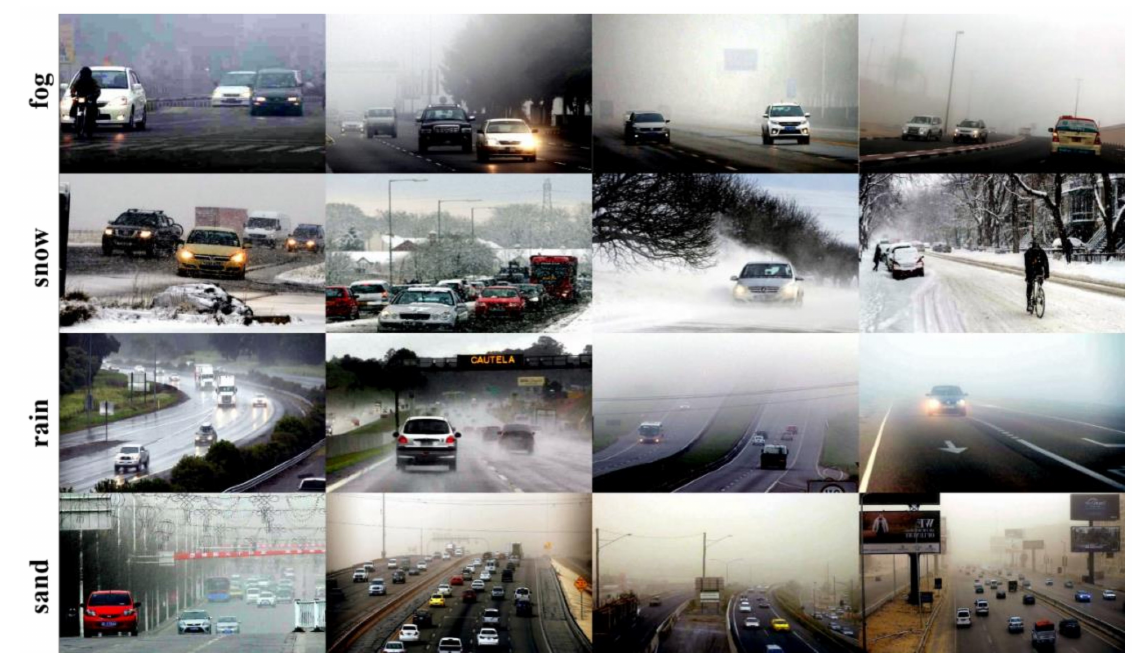
Figure 3. Image after auto color levels algorithm